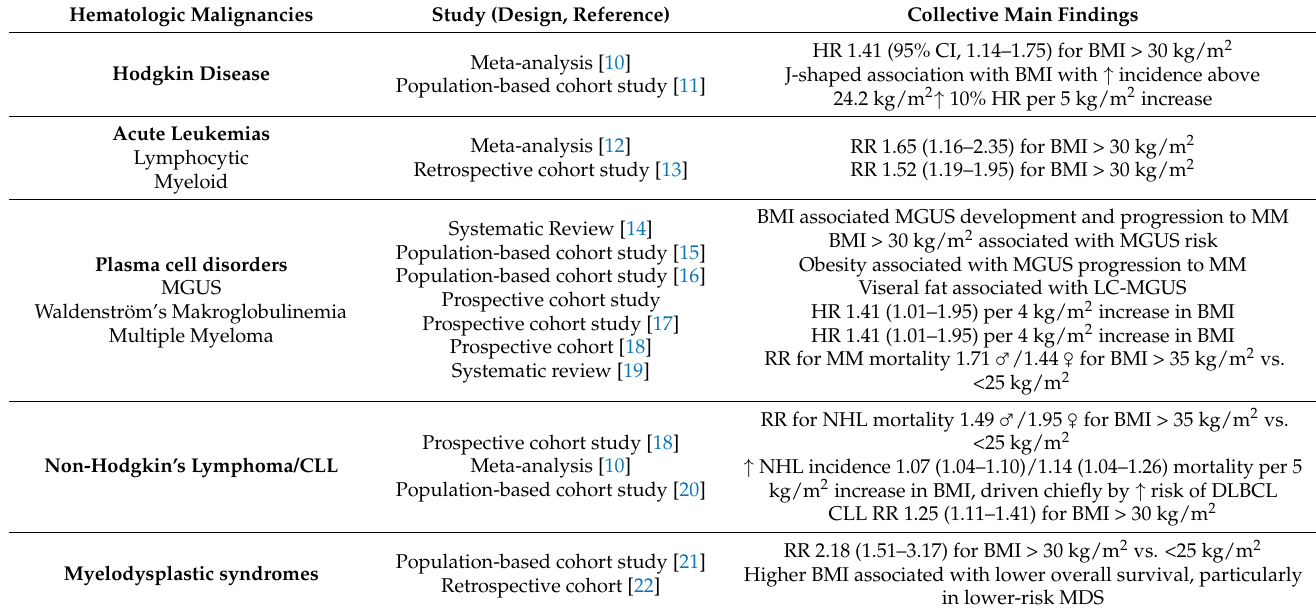
Table 1. Overview of obesity-related hematologic